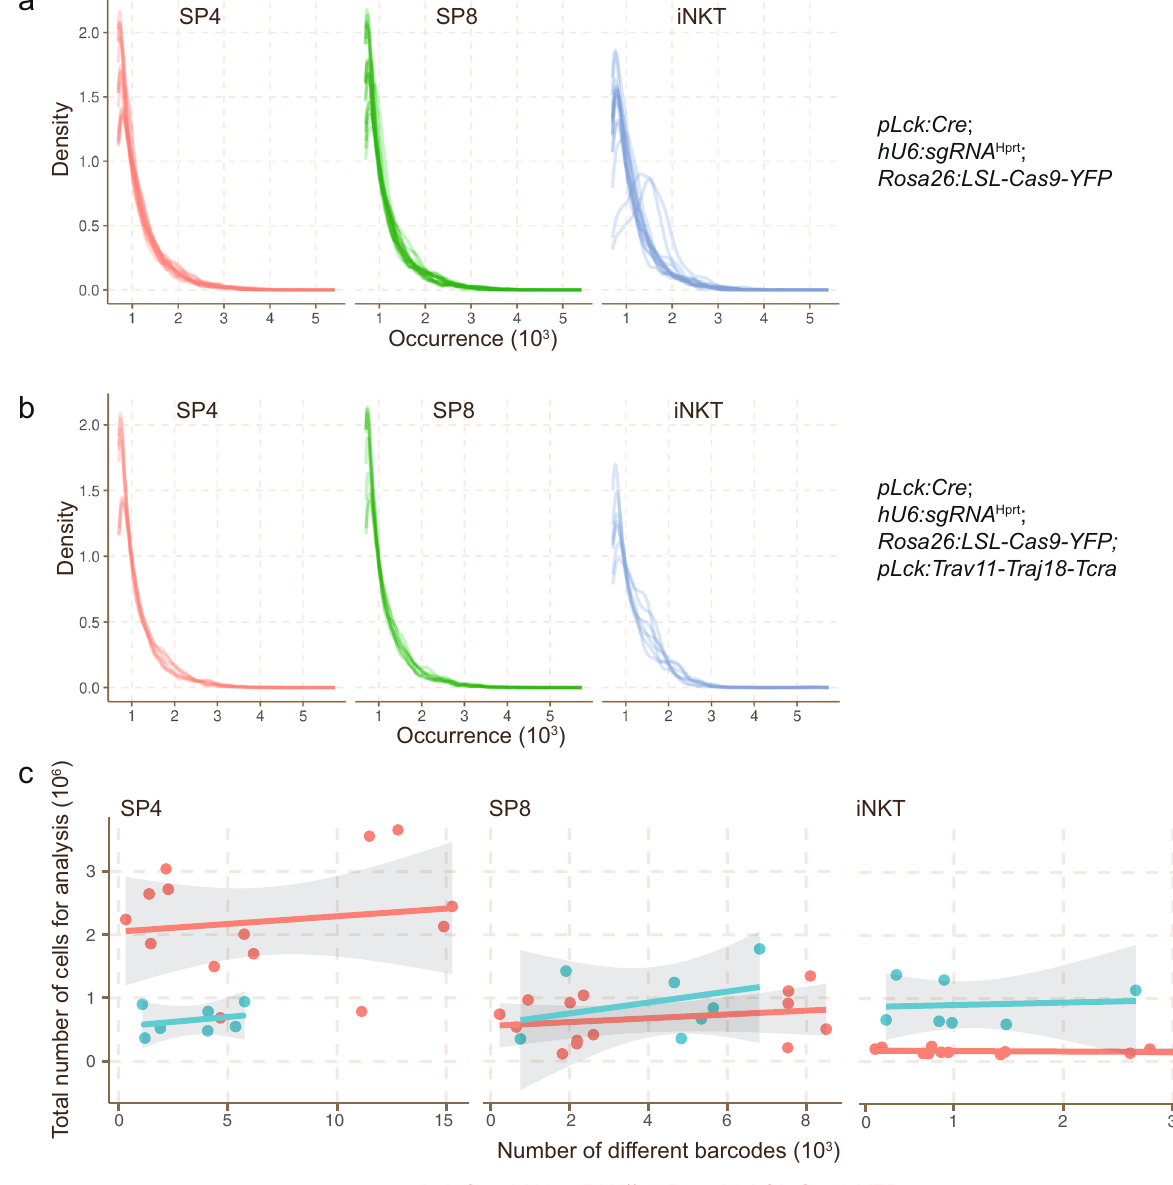
Fig. 2 Frequency of barcodes. a , b Frequency distributions of barcodes recovered from individual thymocyte populations in mice of the indicated genotypes. c Number of barcodes recovered from individual thymocyte populations in mice of the indicated genotypes as a function of cell